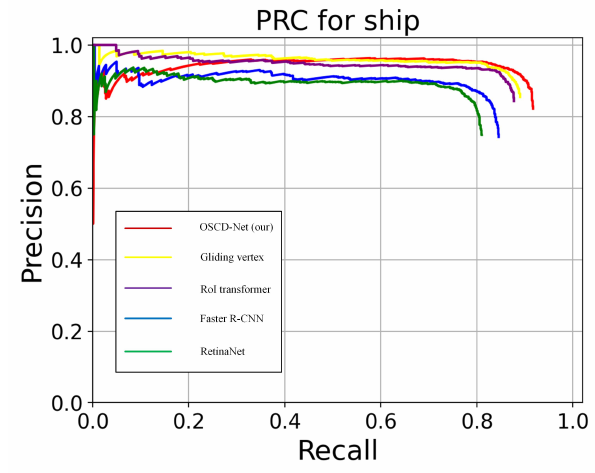
Figure 15. Precision–recall curve of different methods on the SSDD+ dataset.